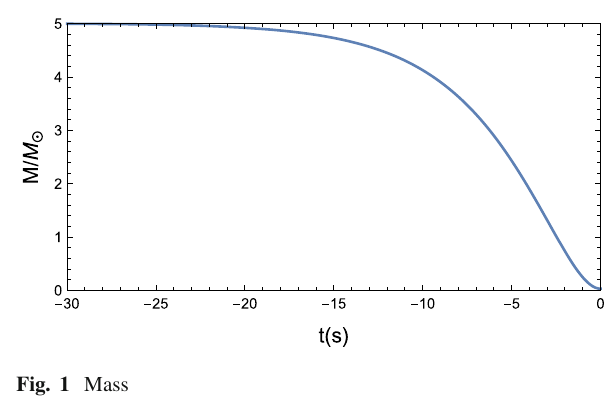
Charan [25] in which both metric functions A and B are spatially and temporally separable. In particular, the time dependence was not removed from gravitational potential A ( r , t ) = A 0 ( r ) f ( t ) as it is common to set A ( r , t ) → A 0 ( r ) zon formation and comparison may be made with systems which follow the perturbative approach [26].